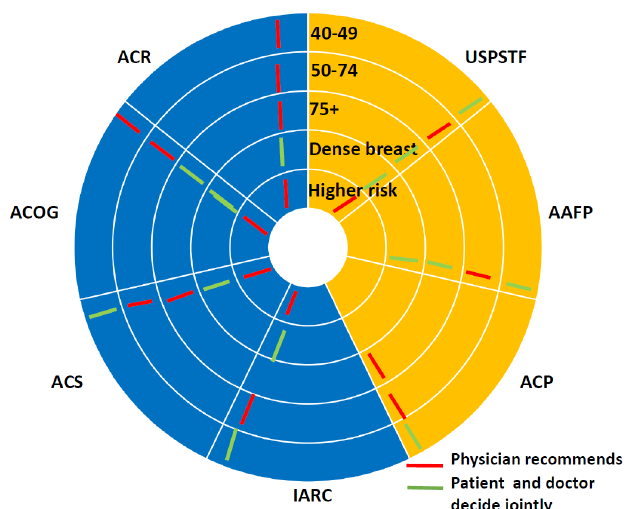
Figure 3. Similarities and disagreements in summarized recommendations. The yellow coloring shows patient making decisions, the blue coloring shows explicit screening recommendations. The concentric circles show different age groups. Red marks—physician recommends, green marks— patient decides.